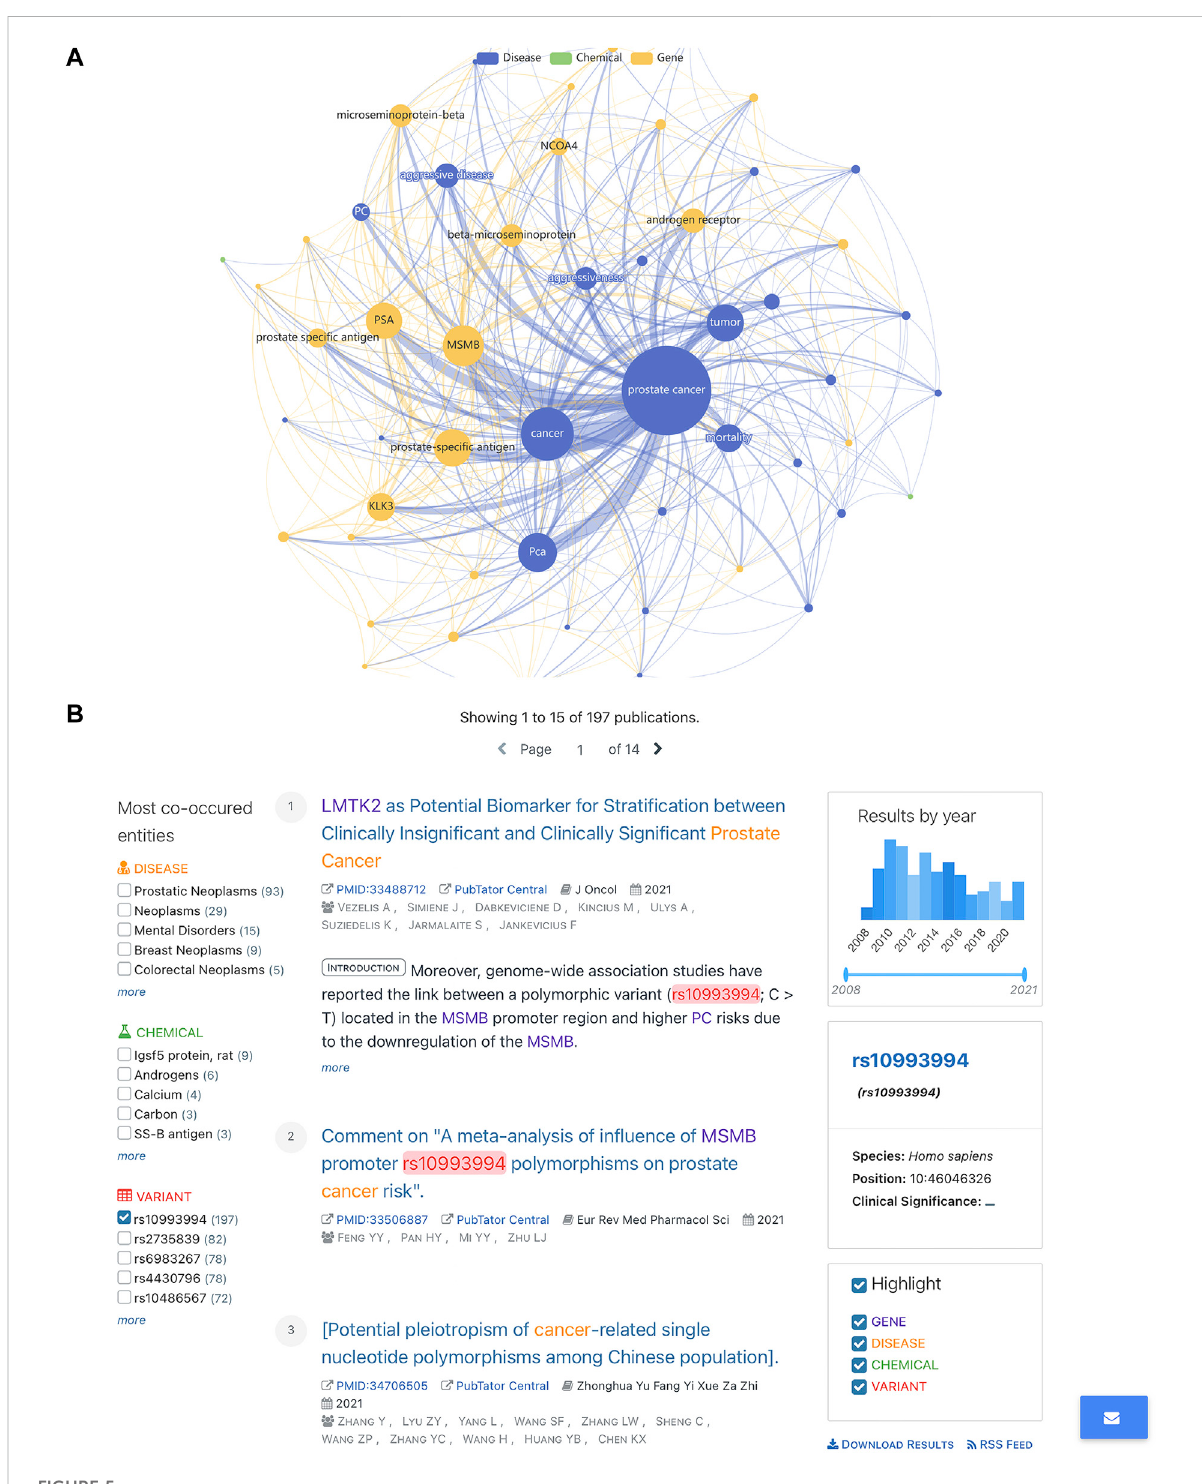
FIGURE 5 Comparing SNPMap with LitVar. (A) rs10993994 in SNPMap. (B) rs10993994 in